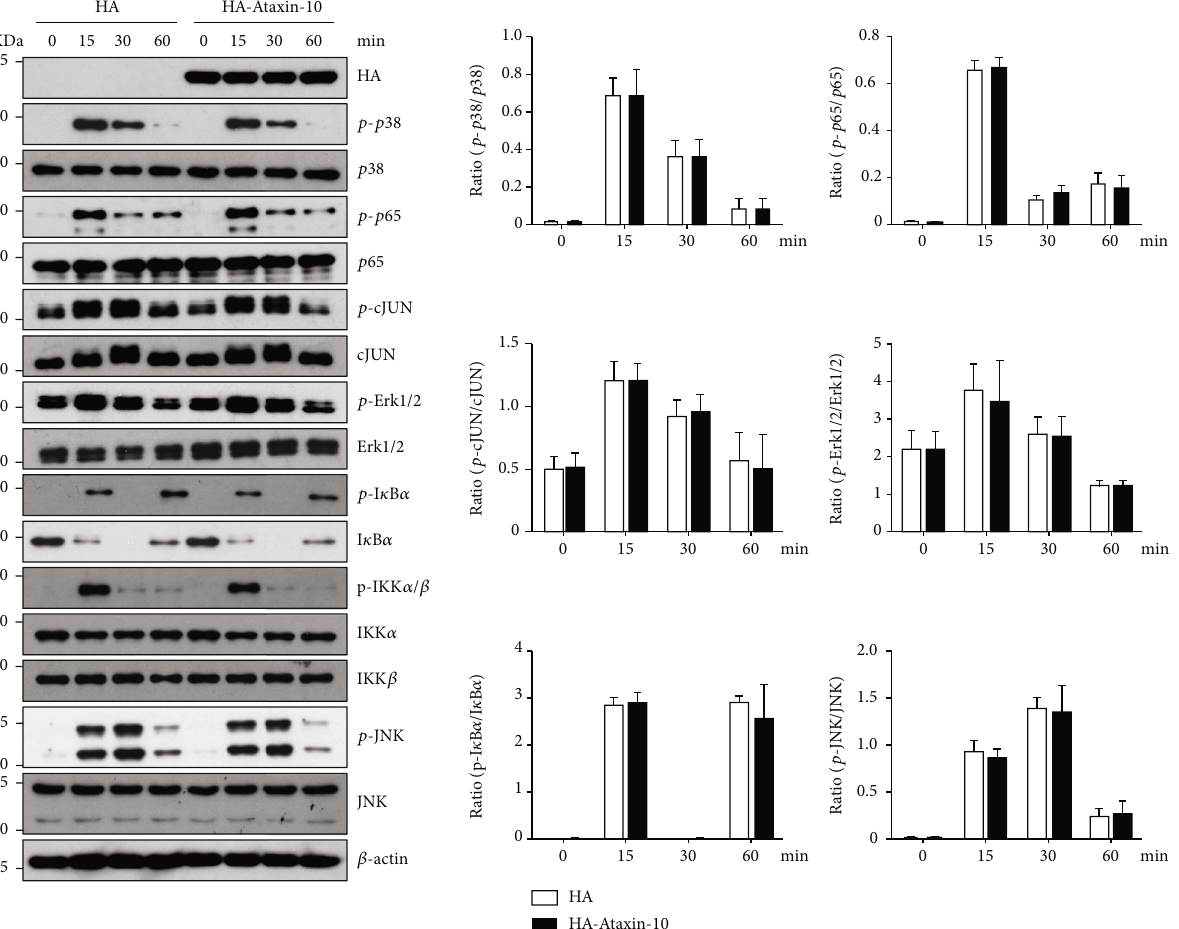
Figure 5: E ff ect of Ataxin-10 on MAPK/NF- κ B signaling pathway in TNF- α -stimulated HUVECs. HA-Ataxin-10 or empty vector was transfected into HUVECs and then stimulated with TNF- α for the indicated times, and whole cell lysates were prepared and harvested for immunoblotting. Blots for activated p38 (phospho-p38 Thr180/Tyr182), activated p65 (phospho-p65S536), activated c-JUN (phospho-c-JUN Ser63), activated ERK (phospho-ERK T202/Y204), activated I κ B α (phospho-I κ B α Ser32), activated IKK α / β (phospho- IKK α / β Ser176/Ser177), and activated JNK (phospho-JNK T183/Y185) are shown. Internal loading is shown by antiactin or reprobing membranes with antibodies to total p38, p65, c-JUN, ERK1/2, I κ B α , IKK α , IKK β , and JNK immunoblotting. The bands of Western blotting were quanti fi ed by Gel-Pro Analyzer software, and the results were presented as fold changes at the right side of the